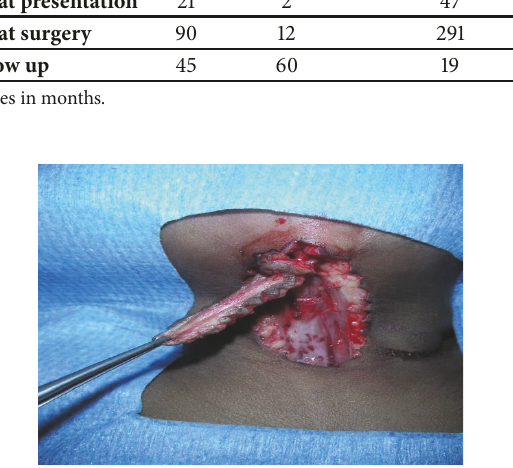
Figure 2: Perioperative view showing the excision of the